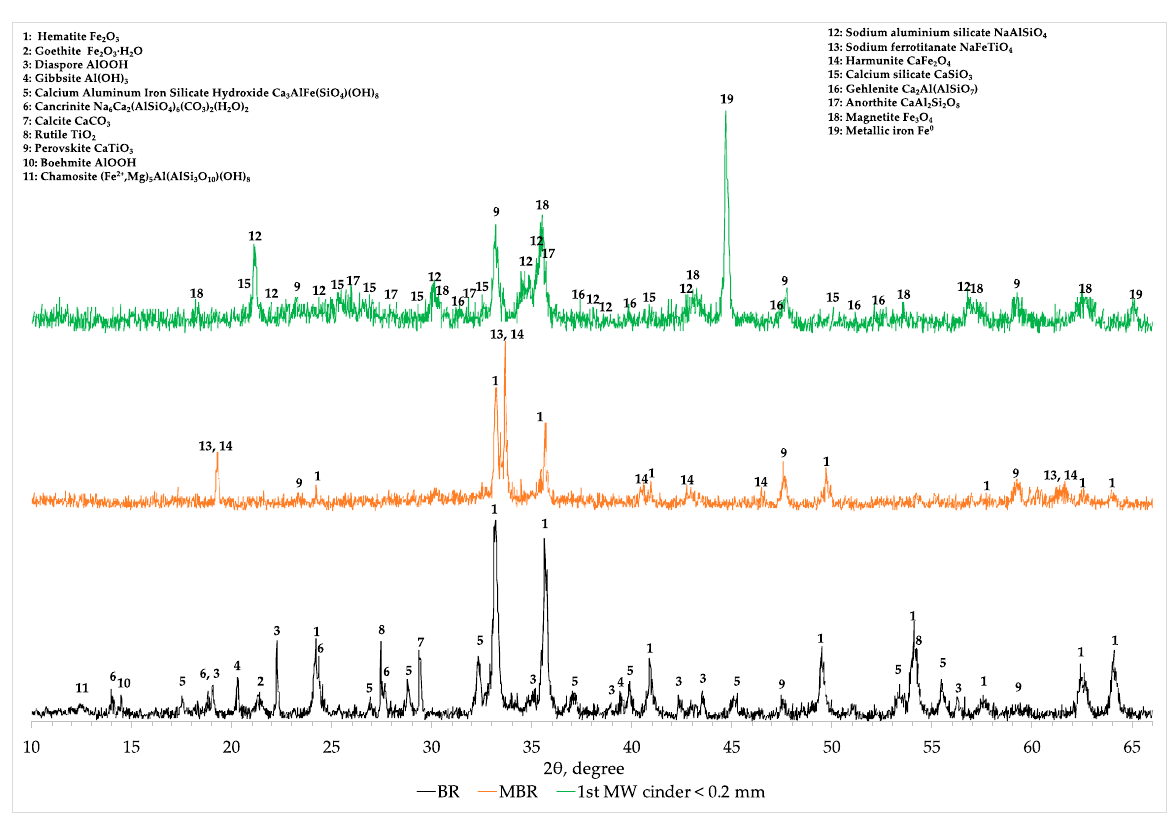
Figure A1. Comparison of XRD profiles of bauxite residue, modified BR and 1st cinder fraction with particle size <0.2 mm.